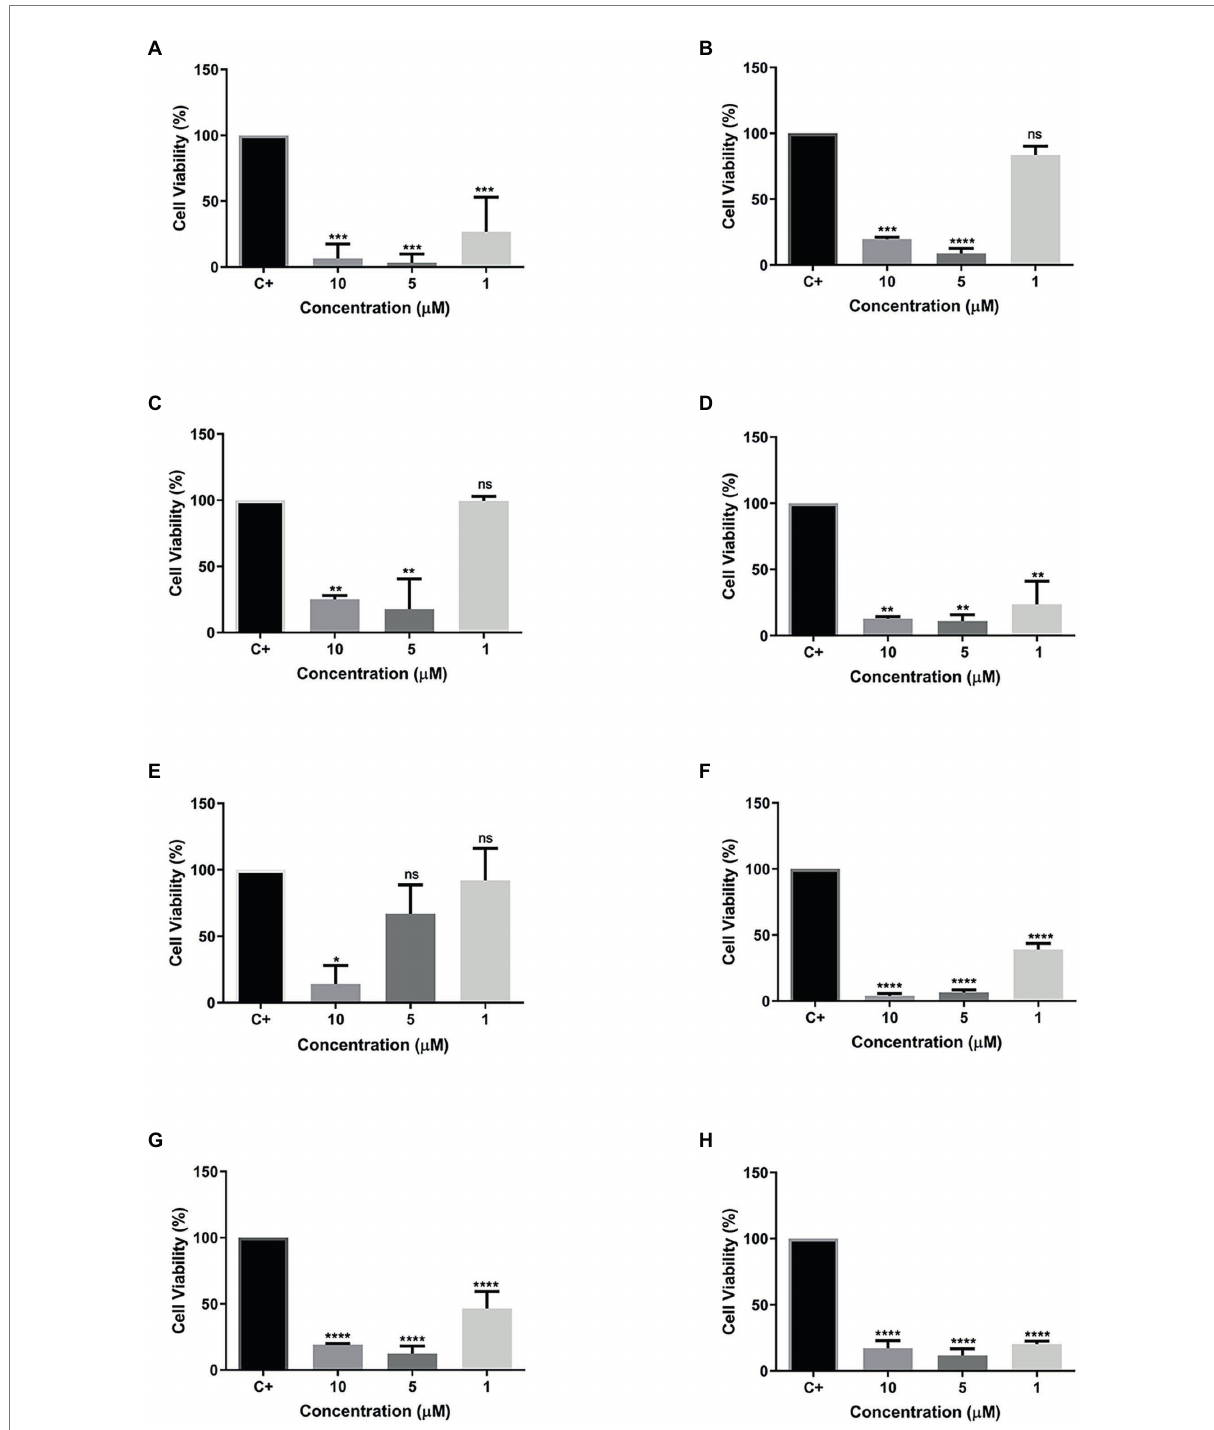
FIGURE 6 Cell viability of synthetic peptides tested against SF21 cell line at concentrations of 10, 5, and 1 μ M. (A) Cu-1a; (B) R1a; (C) R1b; (D) R2b; (E) R3b; (F) R6b; (G) R8b; and (H) R10b. One-way ANOVA—Bonferroni’s multiple comparisons test. Each bar represents the mean ± SD of cellular absorbance; N = 3. * p < 0.05, ** p < 0.01, *** p < 0.001, **** p < 0.0001, and NS p >